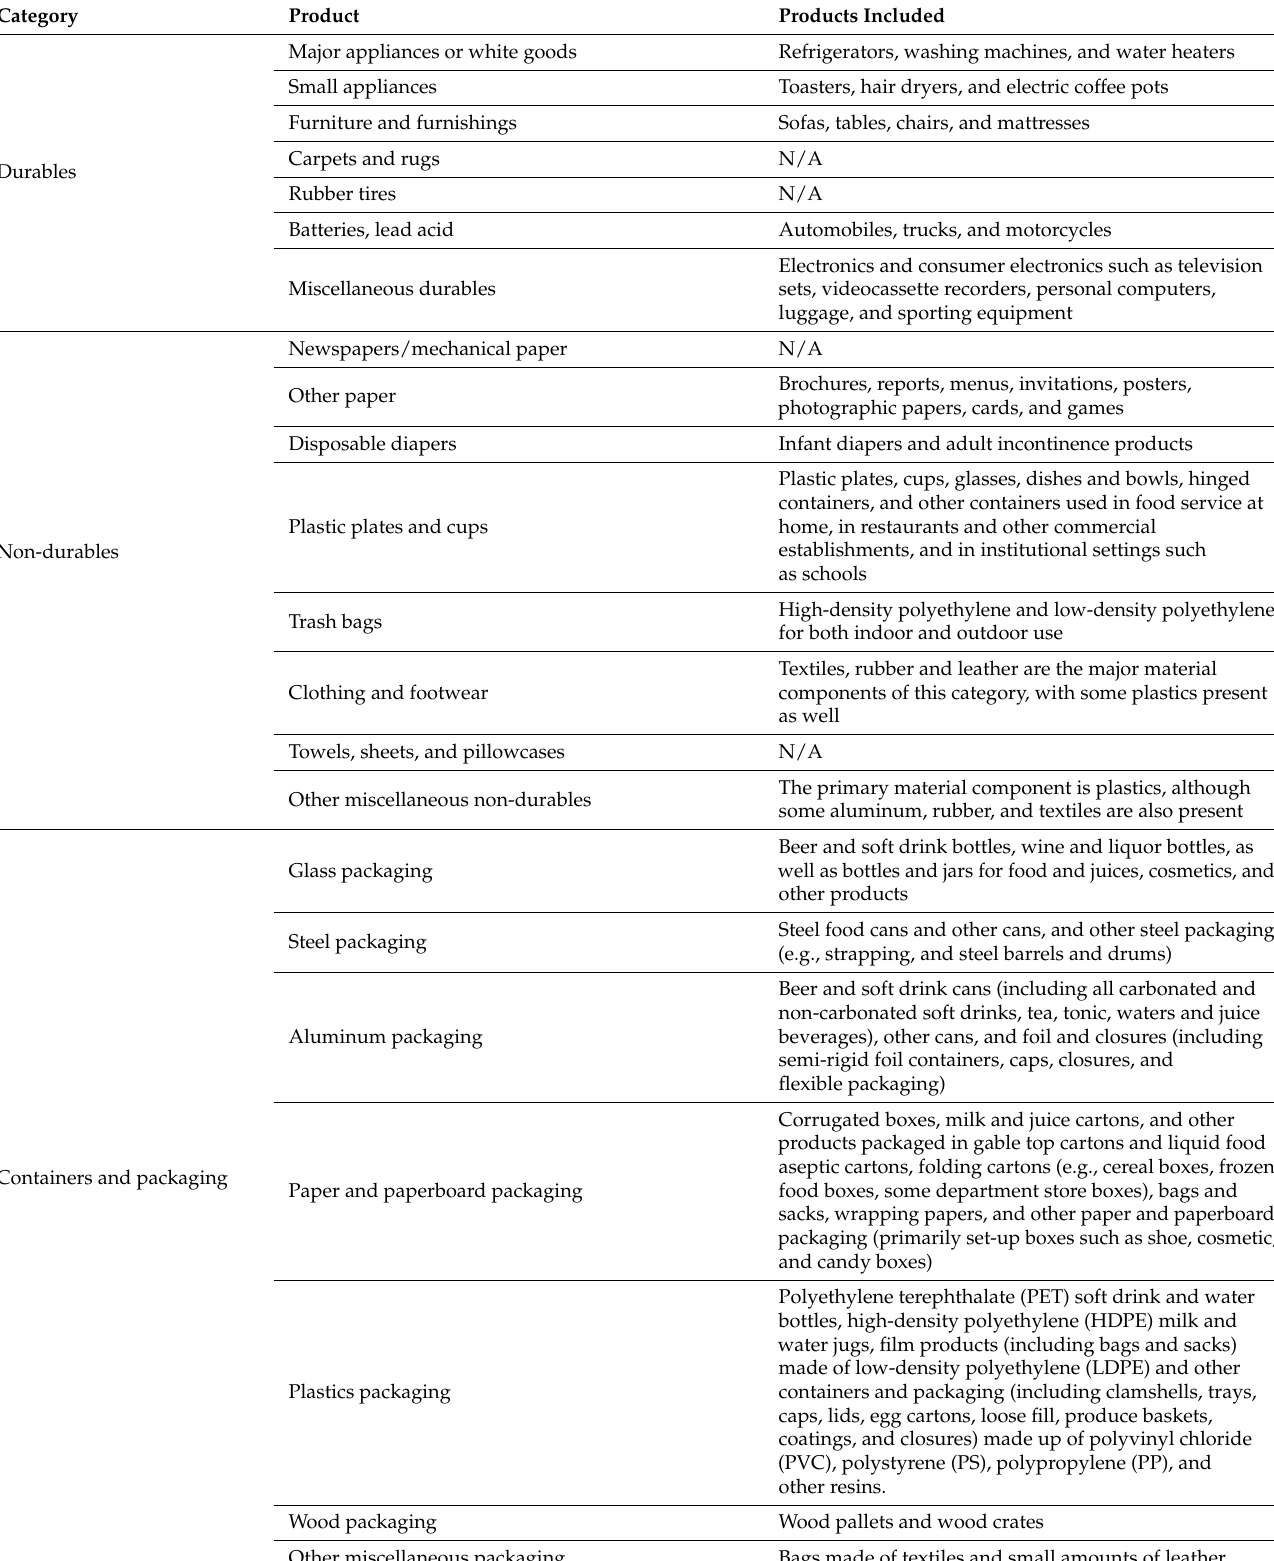
Table 1. Products considered in this study